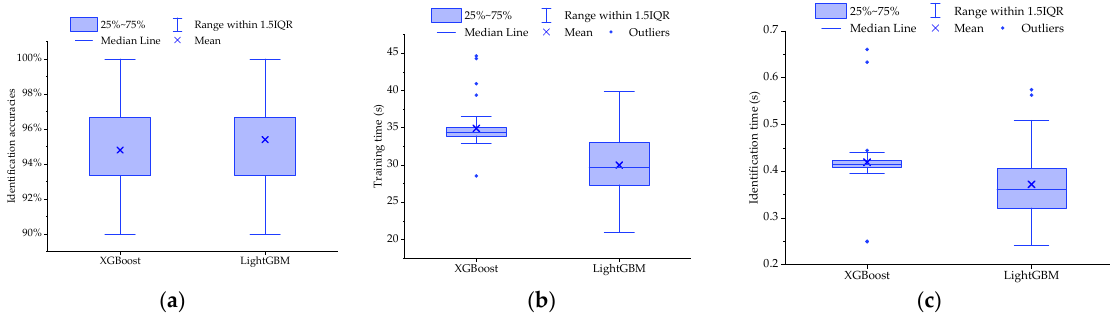
Figure 10. Statistical results obtained in perfume experiments. ( a ) Boxplot of the identification accuracies. ( b ) Boxplot of the time spent for training. ( c ) Boxplot of the time spent for identification.